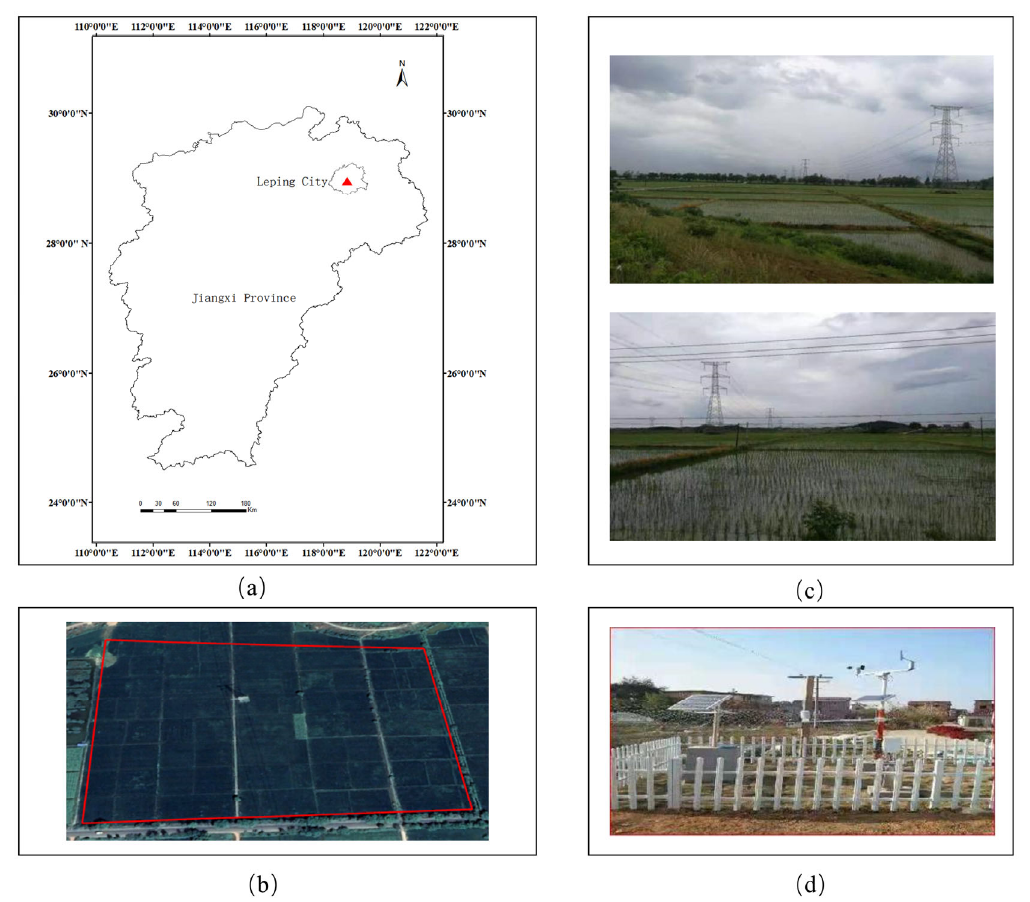
Figure 1. Study area. ( a ) Location. ( b ) Google Earth image. ( c ) Field survey images. ( d ) Phenological observation stations.